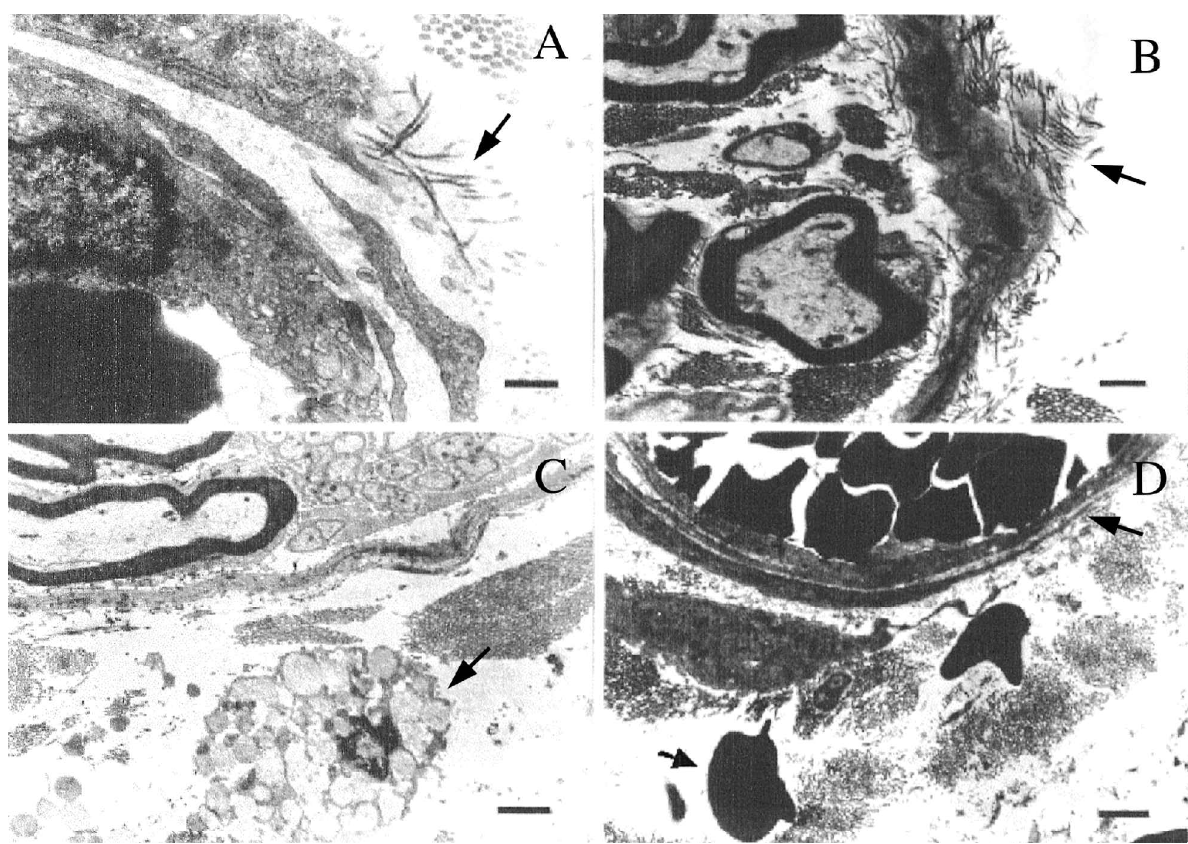
FIG. 1. Electron micrographs of the connective tissue of scrotal bag of a rat 1min after injection of 2.5 m g of B. jararaca venom. Arrows indicate: (A) disorganisation of perivascular collagen fibres (bar= 0.25 m m); (B) disorganisation of perineural collagen fibres (bar = 0.5 m m); (C) mast cell degranulation near a nerve bundle (bar= 1 m m); and (D) vascular congestion and haemorrhage (bar= 1 m